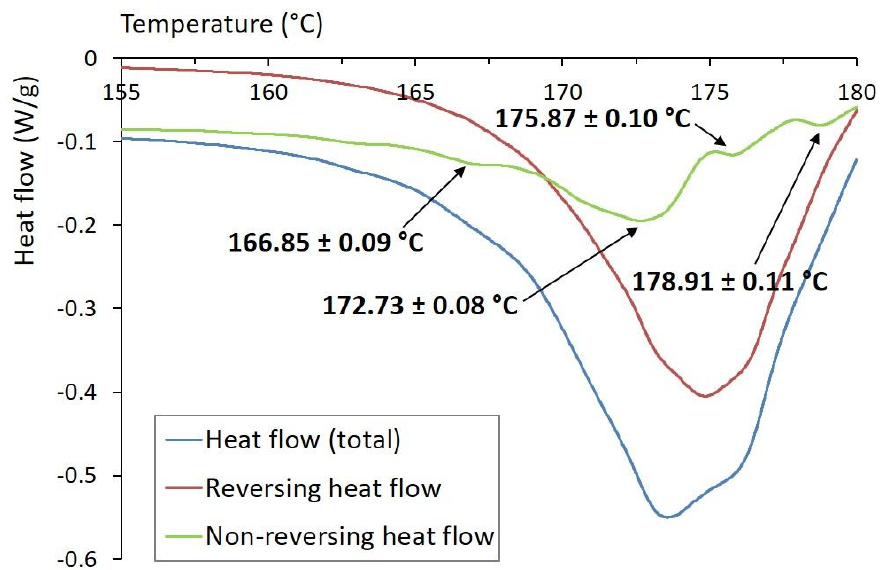
Figure 2. MDSC total heat flow pattern, and its reversing and non-reversing components, of studied curcumin powder.